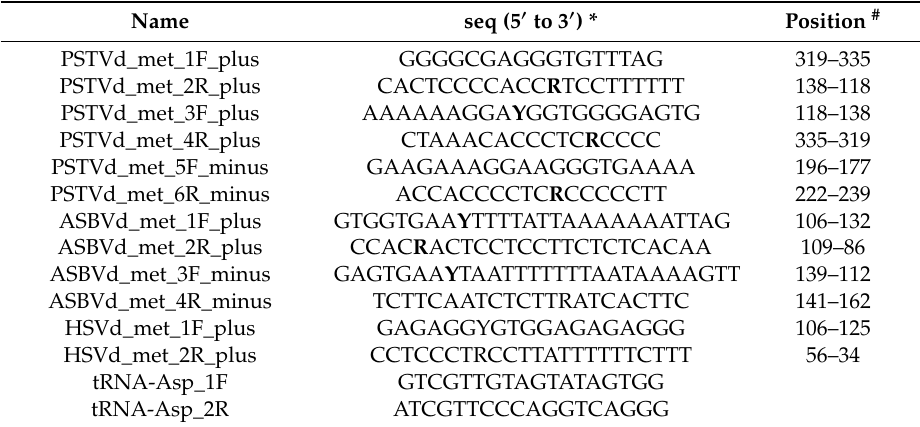
Table 1. Primers used in this